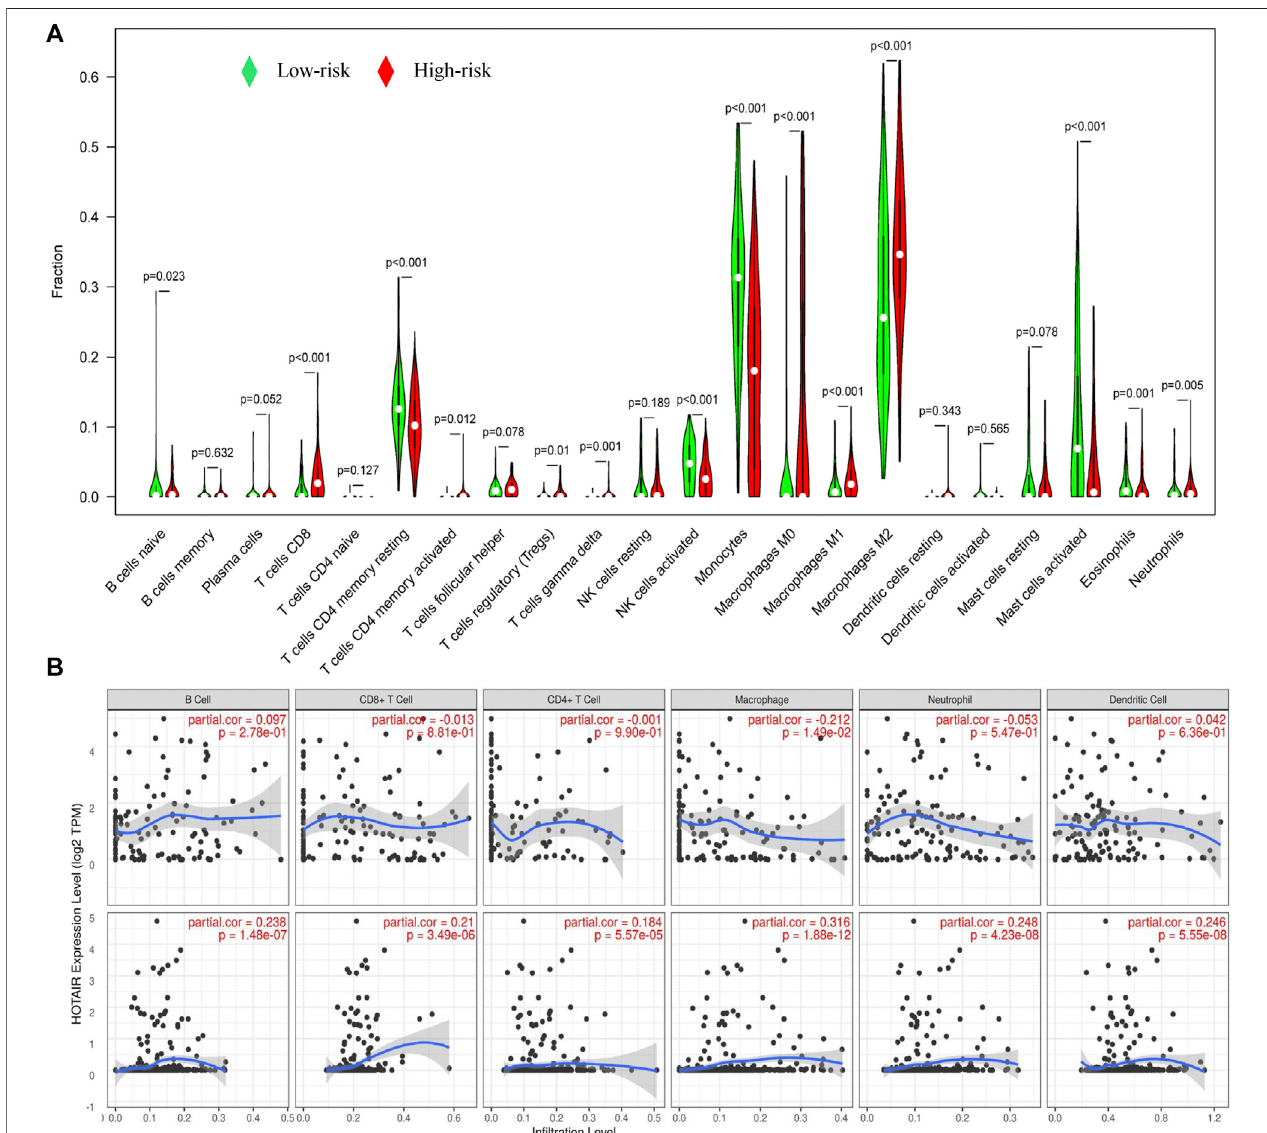
FIGURE 8 | Relationship between GILncSig and immune cell in fi ltration. (A) Distribution of immune cell in fi ltration in the high- and low-risk groups. Red represents the high-risk group, and green represents the low-risk group. (B) Effect of one lncRNA of GILncSig on immune in fi ltrating cells.